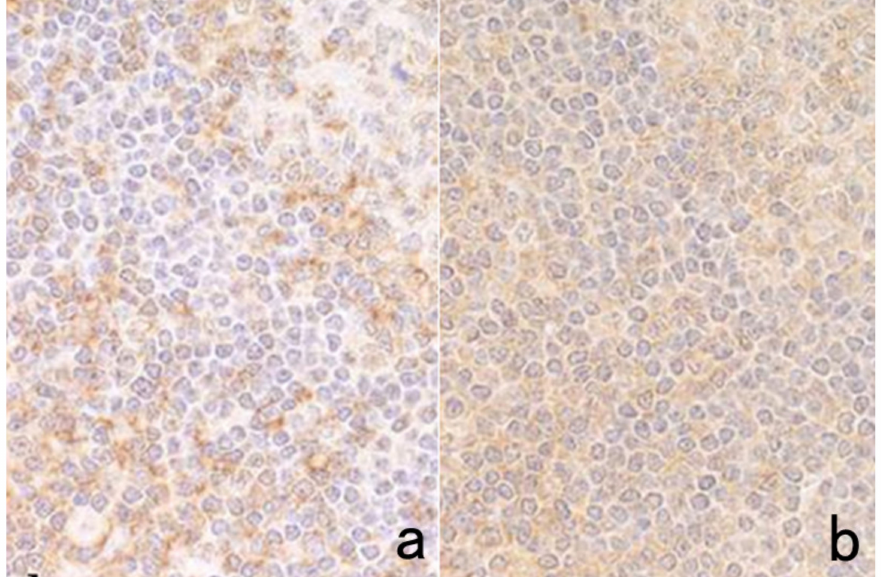
Figure 29. Paradoxical weakening of the antigenicity in CSA-II-mediated chromogenic immunostain- ing when the primary antibody concentration is high. CD4 immunostaining of the pharyngeal tonsil after HIER using CD4 monoclonal antibody diluted at 1:500 ( a ) and 1:50 ( b ). Equivocal CD4 staining on the plasma membrane with a high background occurs when the primary antibody concentration is 10 times higher. The background staining was caused by artificial diffusion of the membrane antigen into the